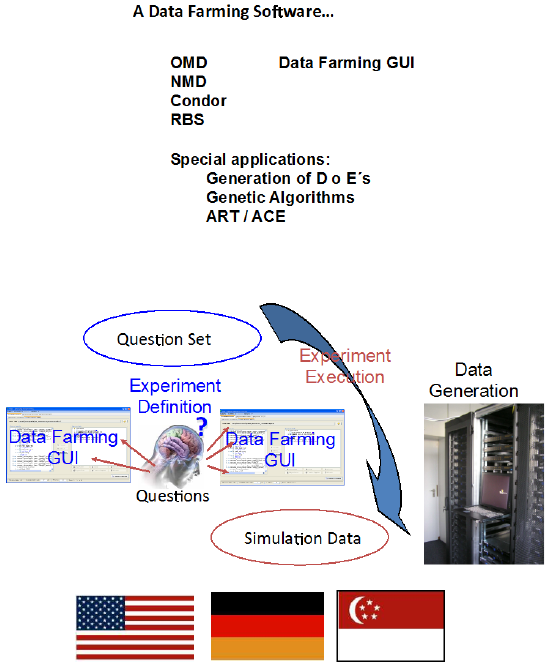
Figure 5. Data Farming software, the experiment execution loop, and contributing nations.